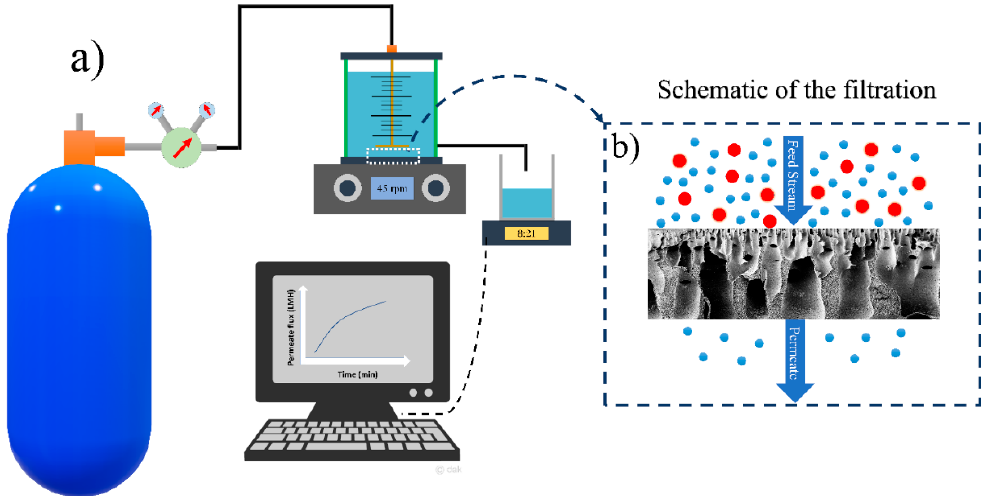
Figure 1. Schematic diagram of ( a ) the dead-end filtration system and ( b ) the filtration mechanism in the